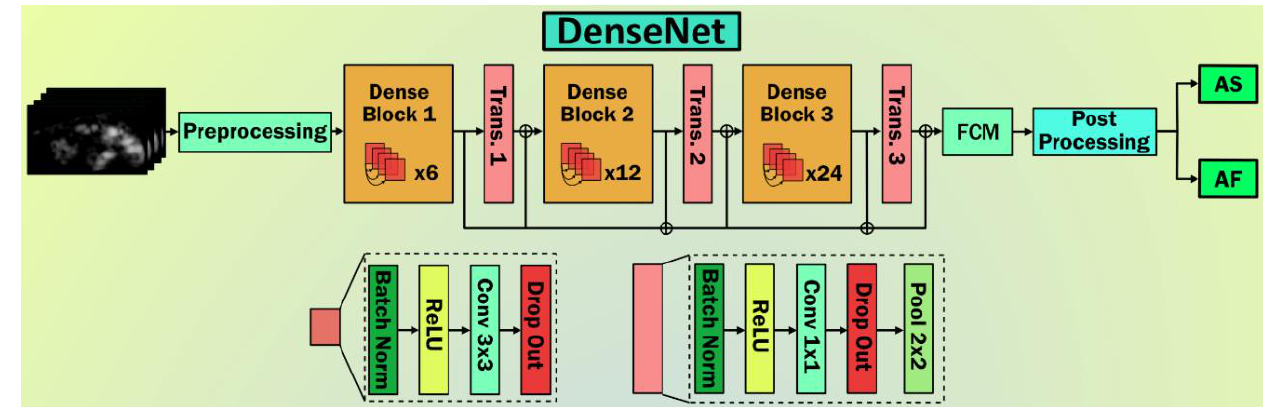
Figure 7. DenseNet architecture with three dense blocks and three transition blocks, followed by the fully connected network. Post processing is represented by softmax.